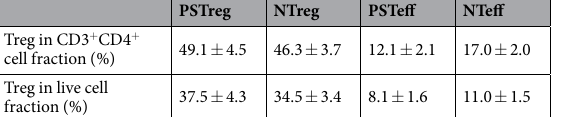
Table 1. Frequency of CD4 + CD25 + CD127 low/ − Foxp3 + cells in PSTreg and NTreg and PSTeff and NTeff populations.